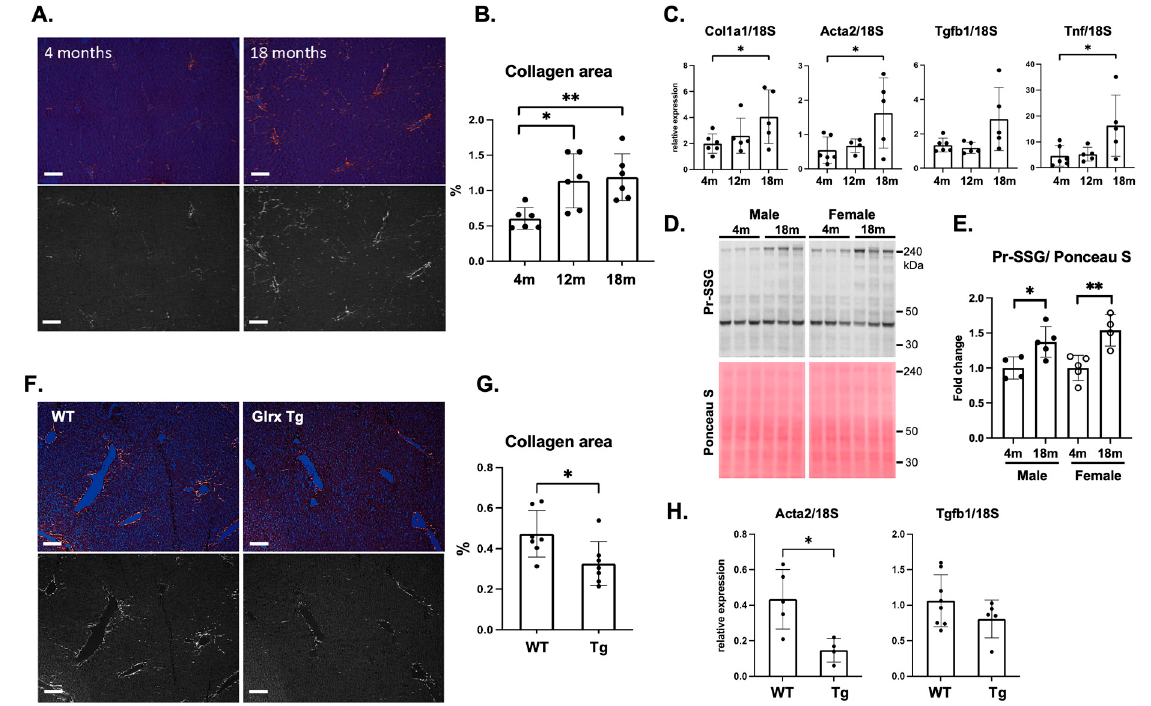
Figure 1. Glrx overexpression inhibits age-induced liver fibrosis in chow-fed mice. ( A ) . Picro Sirius Red staining in the liver of 4- and 18-month-old mice. The original image was taken by a microscope with a polarized filter, with a bright red signal indicating collagen (upper photos). The red channel was converted to grayscale to measure the collagen area by ImageJ (lower photos). Scale bar: 50 um. ( B ) . Quantitative assessment of collagen area (%) ( n = 6 mice each age, males, and females). ( C ). Real- time PCR for fibrosis marker genes in the liver ( n = 5–6, males, and females). Col1a1: collagen type 1, alpha 1; Acta2: alpha-actin 2; Tgfb1: transforming growth factor-beta 1; Tnf: tumor necrosis factor. Relative quantity normalized to 18S is shown. ( D ) . Total S -glutathionylated protein level (Pr-SSG) in the mouse liver at 4 and 18 months old. ( E ) . Semi-quantitative analysis of the blots of Pr-SSG normalized by Ponceau S staining is shown in the graph ( n = 4). ( F ) . Representative images of Picro Sirius Red staining in aged wild type (WT) and Glrx transgenic (TG) mouse liver. The original (upper) and grayscale extracted red channel (lower). Scale bar: 50 um. ( G ) . Quantitative assessment of collagen accumulated area (%) ( n = 7, males and females, 19–22 months old). ( H ) . Real-time PCR analysis for fibrosis genes in aged WT and Glrx TG liver. * p < 0.05, ** p < 0.01. Error bars indicate standard error.